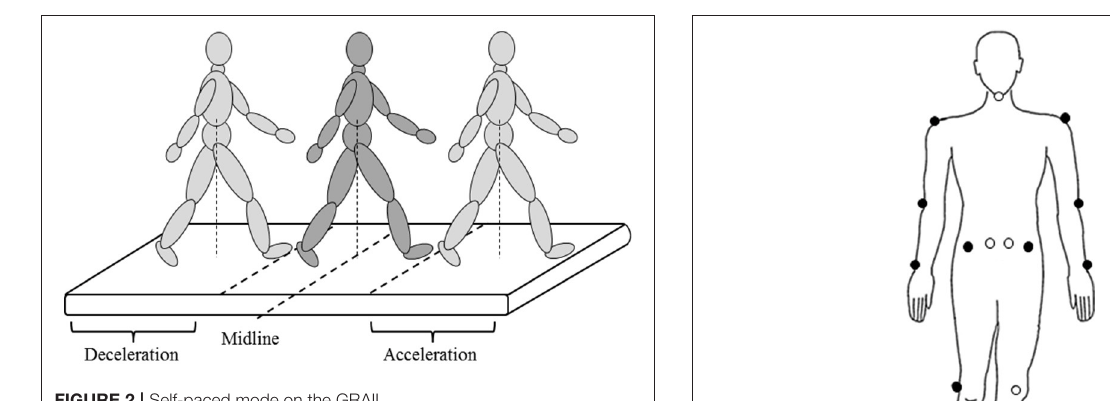
FIGURE 2 | Self-paced mode on the GRAIL.